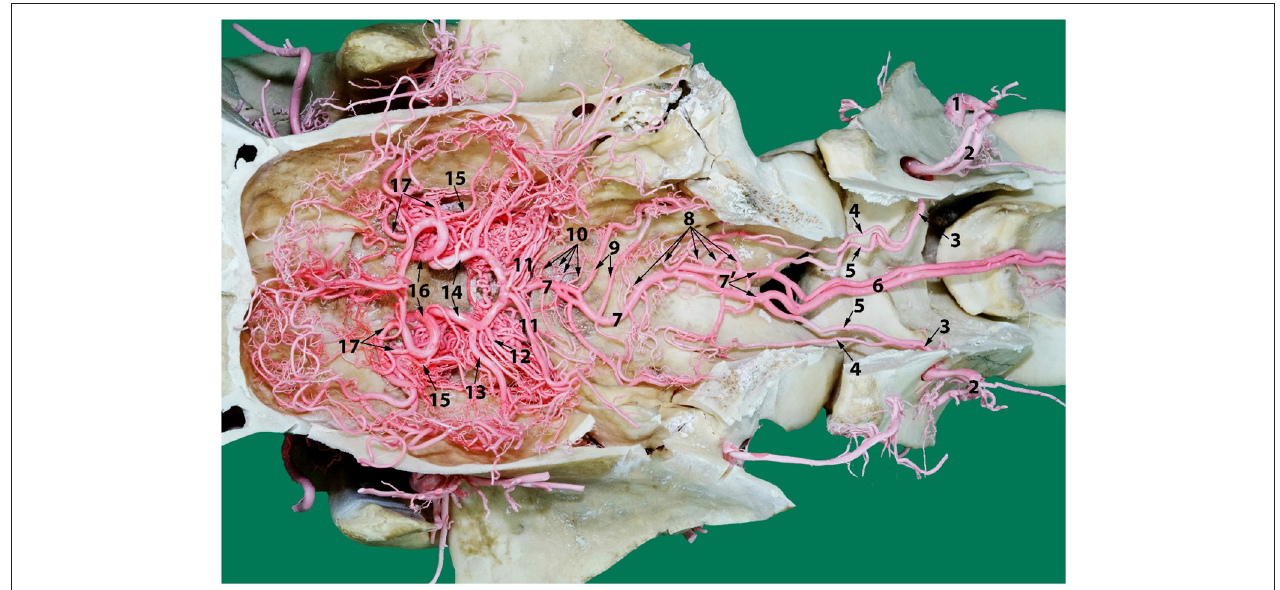
FIGURE 9 | A photograph showing the arterial supply to the dromedary brain (dorsal view) lying on the ventral floor of the cranial cavity and of cervical vertebrae 1 and 2. Here; 1, vertebral artery; 2, dorsal muscular branch; 3, vertebral artery inside the vertebral canal; 4, lateral branch of the vertebral artery; 5, medial branch of the vertebral artery; 6, paired ventral spinal arteries; 7 ’ , right and left segments of the basilar artery; 7, basilar artery; 8, medullary branches; 9, caudal cerebellar artery; 10, pontine arteries; 11, rostral cerebellar arteries; 12, caudal choroidal artery; 13, caudal cerebral artery; 14, caudal communicating artery; 15, rostral choroidal artery; 16, rostral cerebral artery; 17, middle cerebral artery. Note that the RERM lies ventral to the cerebral arterial circle in the cavernous sinus at the base of the cranial